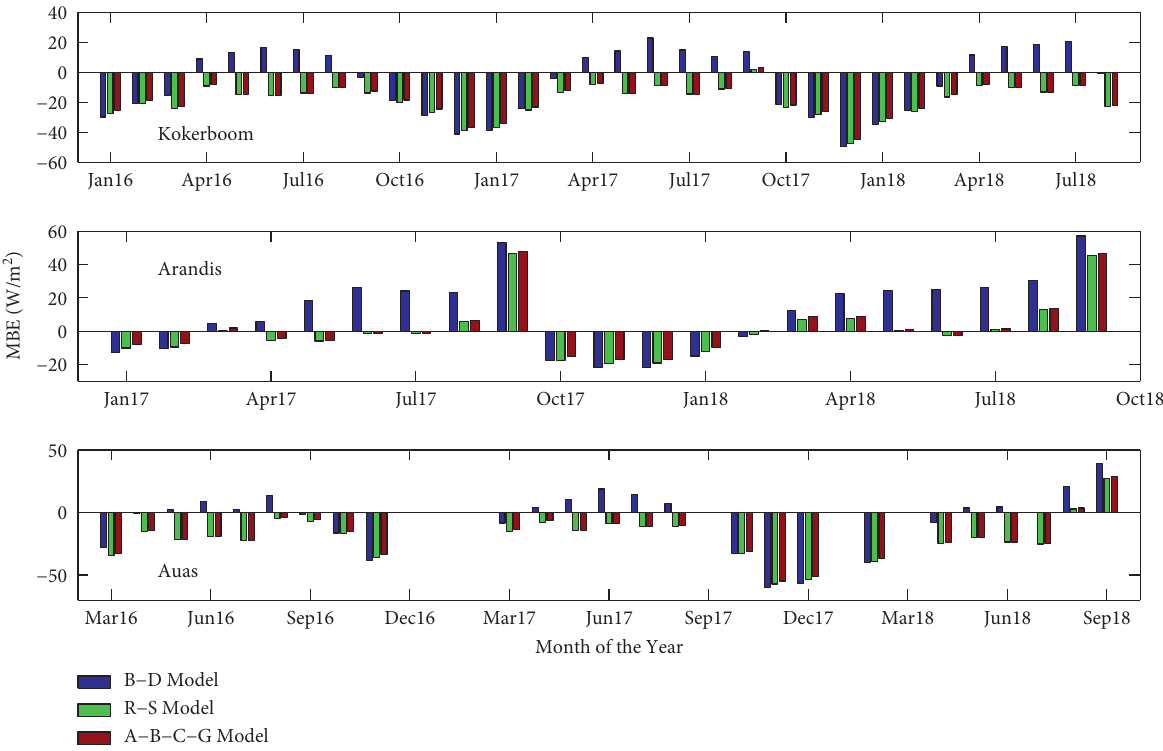
Figure 6: Monthly MBE values for Kokerboom, Arandis, and Auas.